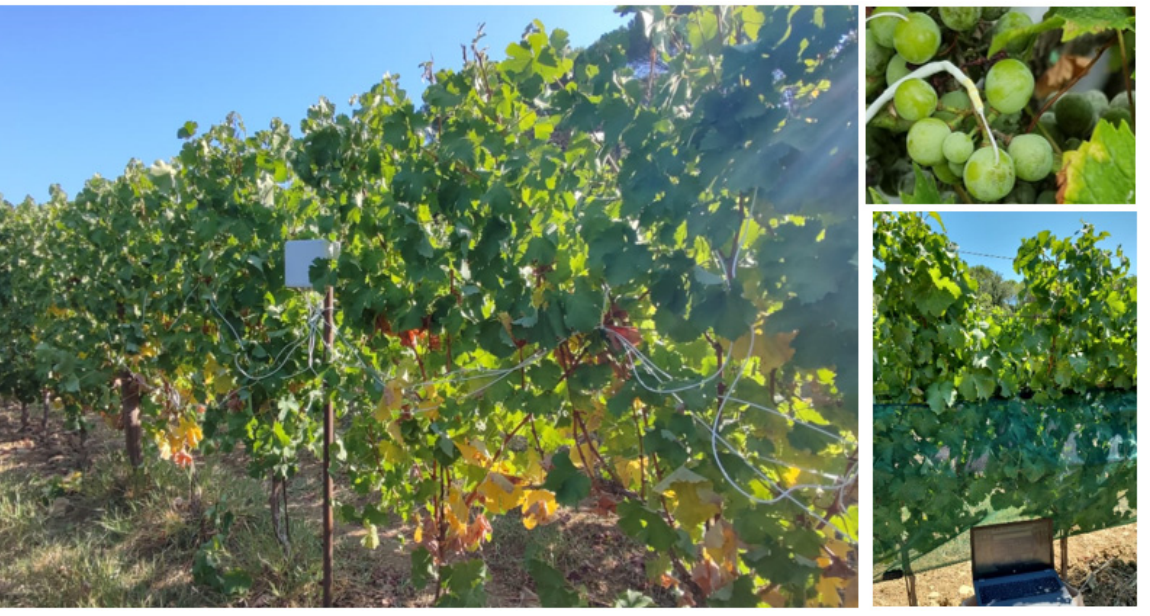
Figure 2. Micro Temperature Probe–GMR_MTP thermocouple inserted into the berry. One hundred berries, selected from the 10 grapevines for the eco-physiological meas- urements, were randomly sampled from each replication of each treatment (10 berries per plant for a total of 100 berries per sample) to accomplish technological maturity ratings.